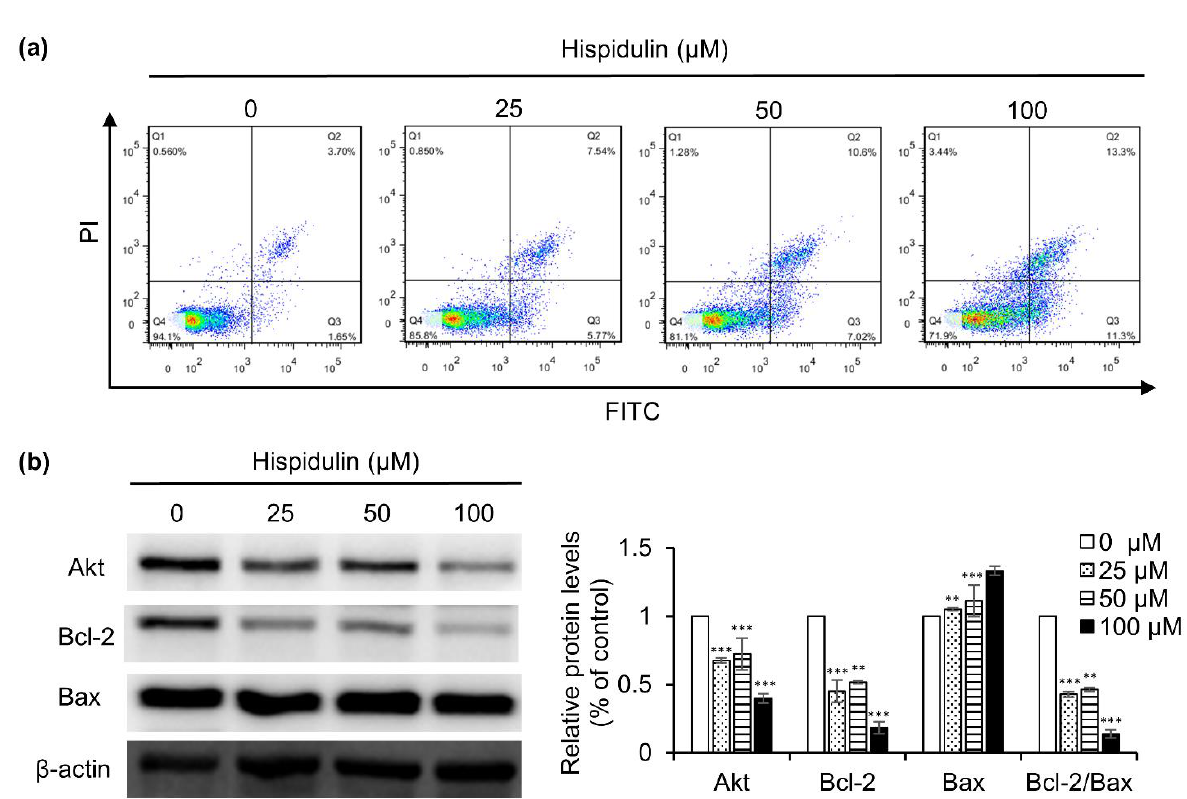
Figure 3. Hispidulin induced apoptosis in CNE-2Z cells. ( a ) CNE-2Z cells were cultured with hispidulin for 48 h and stained by Annexin V and PI staining, then apoptosis rate was determined by flow cytometry. ( b ) The expressions of Akt, Bcl-2, and Bax were analyzed by Western blot. ** p < 0.01, *** p < 0.001 vs. control.